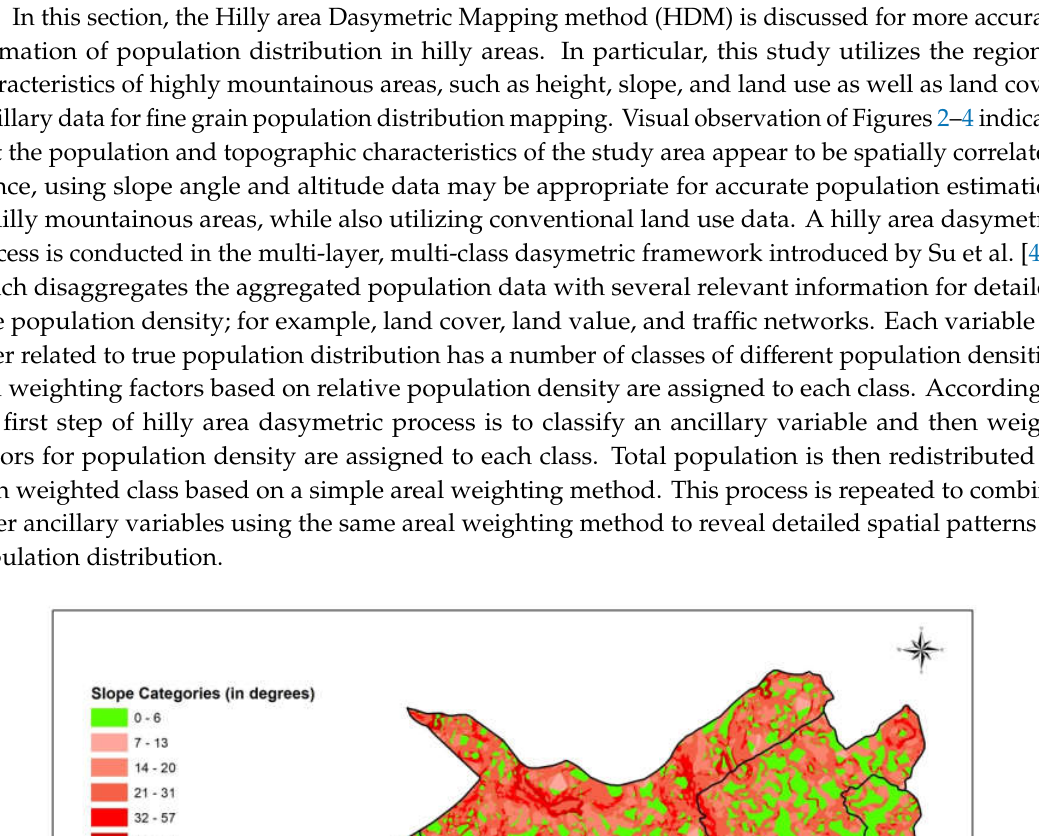
Figure 4. Elevation distribution of the study area.